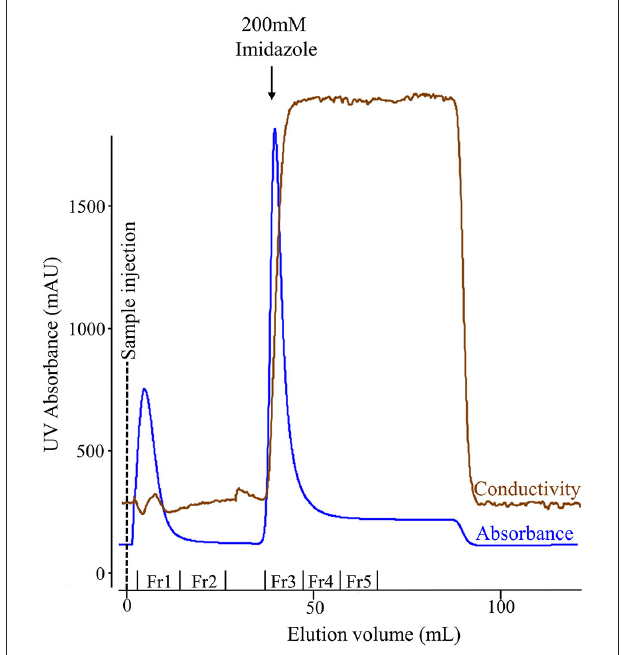
FIGURE 3 | Nickel column chromatography of the soluble protein extracted from E. coli using 3% acetic acid. The chromatogram shows fractions comprising proteins that failed to bind the column in 20 mM imidazole (flow-through: fractions 1–2) and bound proteins eluted when the imidazole concentration was increased from 20 to 200 mM (fractions 3–5). The conductivity trace indicates the increase in imidazole concentration in the buffer flowing through the